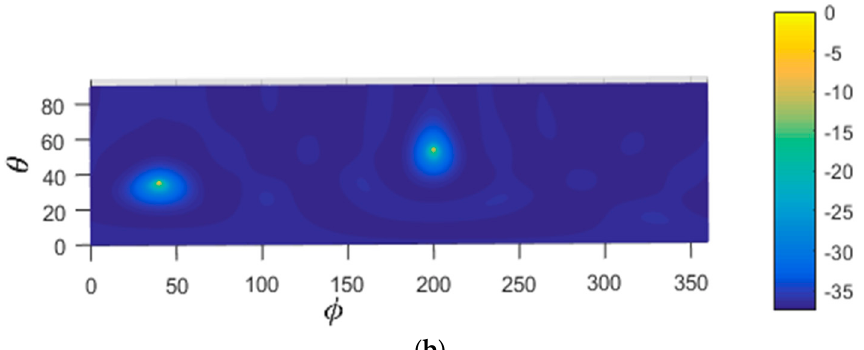
Figure 4. Performance estimation of the PDDA method with two AOAs. ( a ) 3D plot of the PDDA method; ( b ) 2D plot of the PDDA method. Sensors 2017 , 17 , 2631